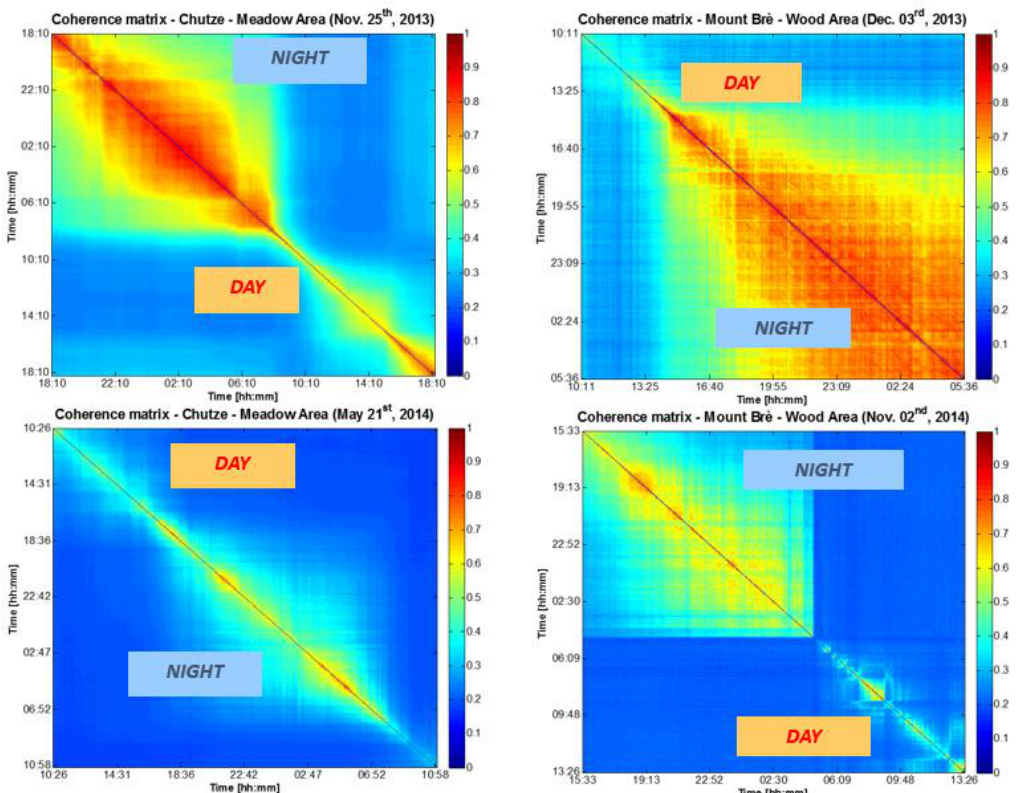
Figure 5. Example of coherence matrixes acquired over meadow ( left ), and forest ( right ) over about one day, in different periods of the year, by Ku-band GBR.